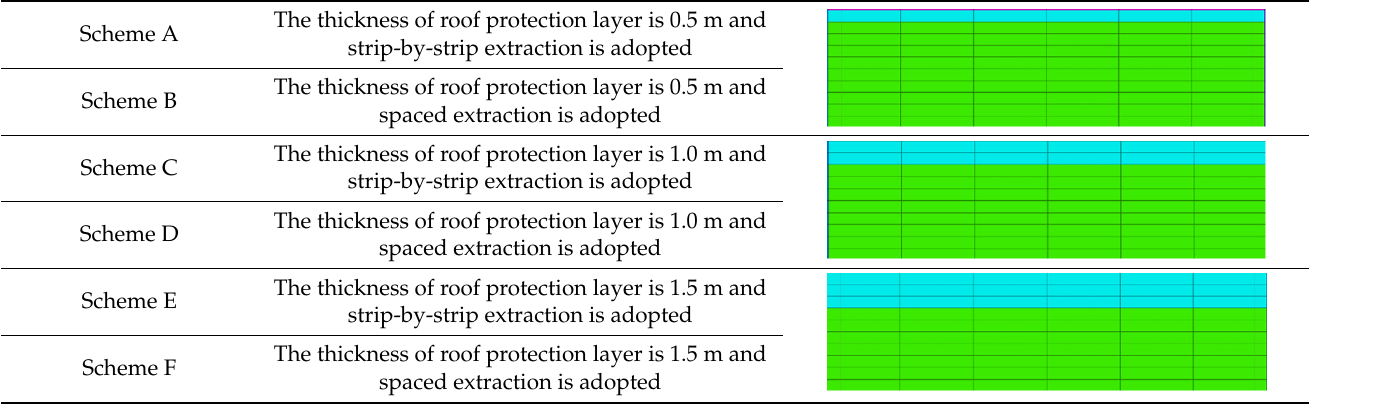
Table 5. Selection of numerical simulation schemes.